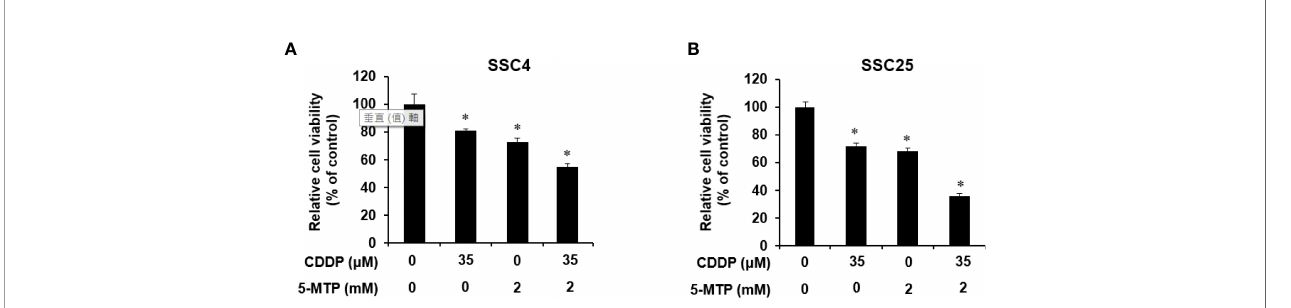
FIGURE 2 | Additional inhibitory effect of the combination treatment of Cisplatin (CDDP) and 5-methoxytryptophan (5-MTP) on the proliferation of SCC4 and SCC25 cells. Combination treatment showed an additional inhibitory effect on the growth of SCC4 (A) and SCC25 (B) cells when compared with the single treatments. Data are presented as the mean ± SD of at least three independent experiments. Asterisks indicate signi fi cant difference in drug-treated cells at indicated concentrations singly in comparison with DMSO-treated cells. *P <